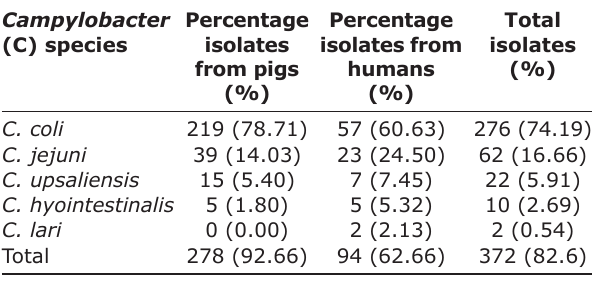
Table-1: Percentage isolation of Campylobacter species in pigs’ and humans’ fecal samples from Zuru Kebbi State.